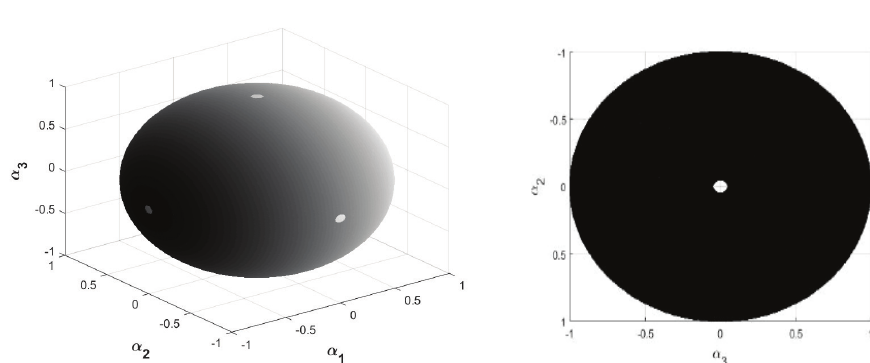
Figure A1. The left figure shows 3 D submanifold typical of the ˘ A family with six topological features. The right figure shows the projection of this submanifold onto the plane ( α 2 , α 3 ) . Recall that similar pictures arise when we projecting manifold on the plane ( α 1 , α 2 ) and ( α 1 , α 3 ) . The second family of ˘ B also consists of six submanifolds ˘ B = ˘ B 1 , ˘ B 6 (see Figure A2).